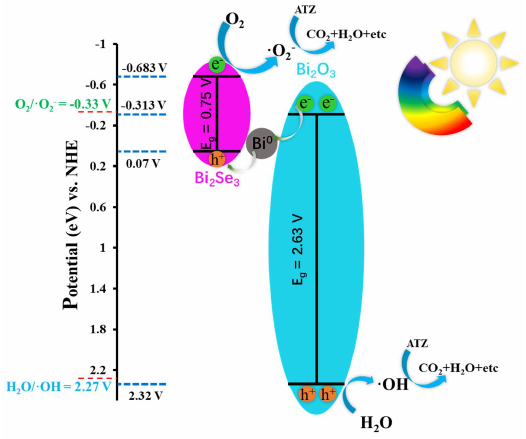
Figure 12. The plausible photocatalytic mechanism of the 2BBOS composite. 4. Conclusions In summary, a flower spherical Bi 2 Se 3 /Bi 2 O 3 @Bi composite photocatalyst was pre- pared by the solvothermal method and the drying oxidation method. The best sample